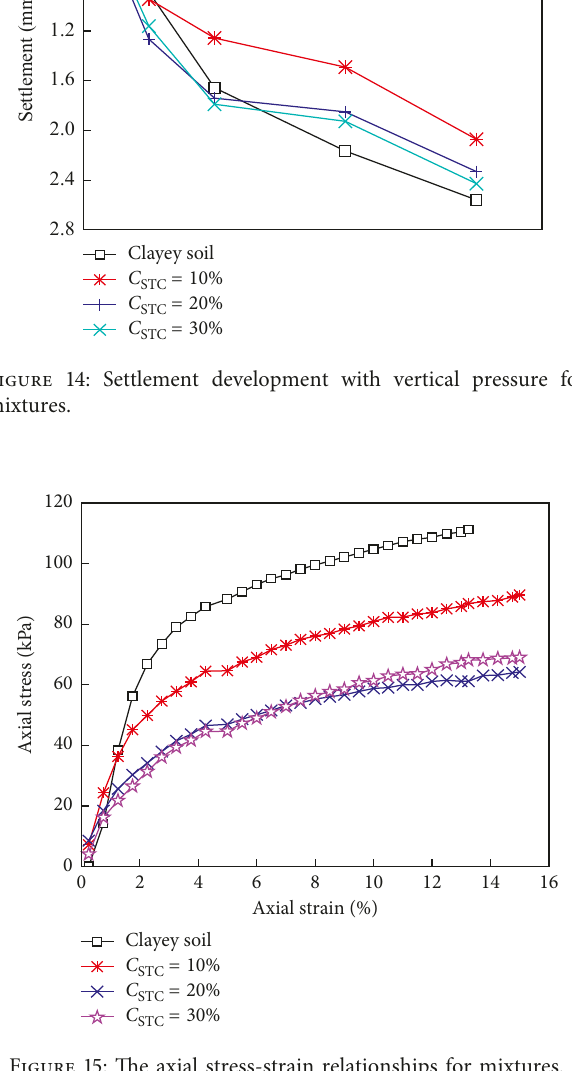
Figure 15: The axial stress-strain relationships for